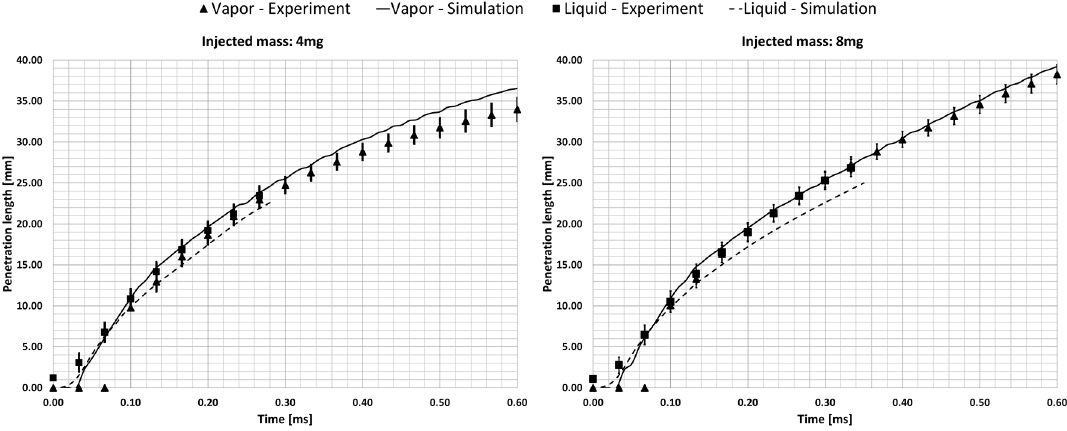
Figure 11. Comparison of the numerical and experimental results of selected test cases; 4 mg and 8 mg diesel masses injected.